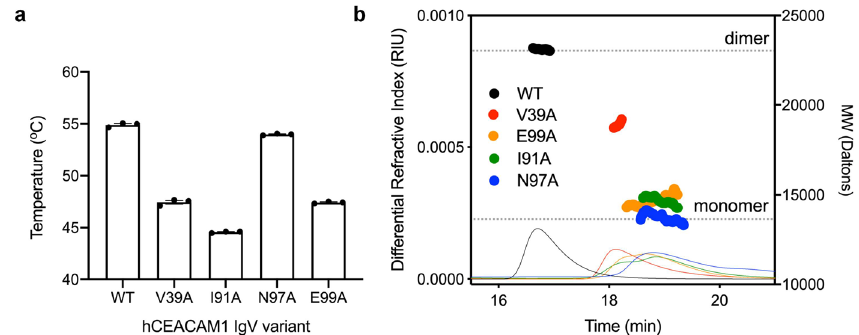
Fig. 1 Biophysical characterization of CEACAM1 IgV mutants. Thermal stability and molecular size analysis of hCEACAM1 WT and GFCC ′ face mutants. a Variations in melting point temperature ( T M ) determined by differential scanning fl uorimetry (DSF) are shown for WT and mutant hCEACAM IgV. b Size exclusion chromatography and multi-angle light scattering (SEC-MALS) differential refractive index (dRI) chromatograms and calculated molecular weights are displayed for WT (black), V39A (red), I91A (green), N97A (blue), and